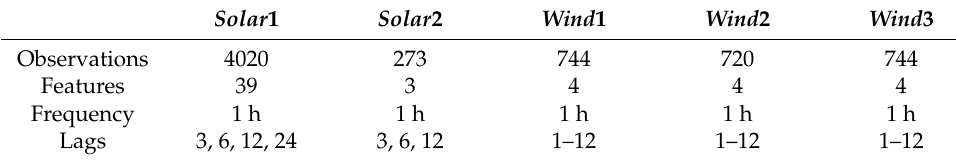
Table 2. Description of the resulting datasets after the preprocessing